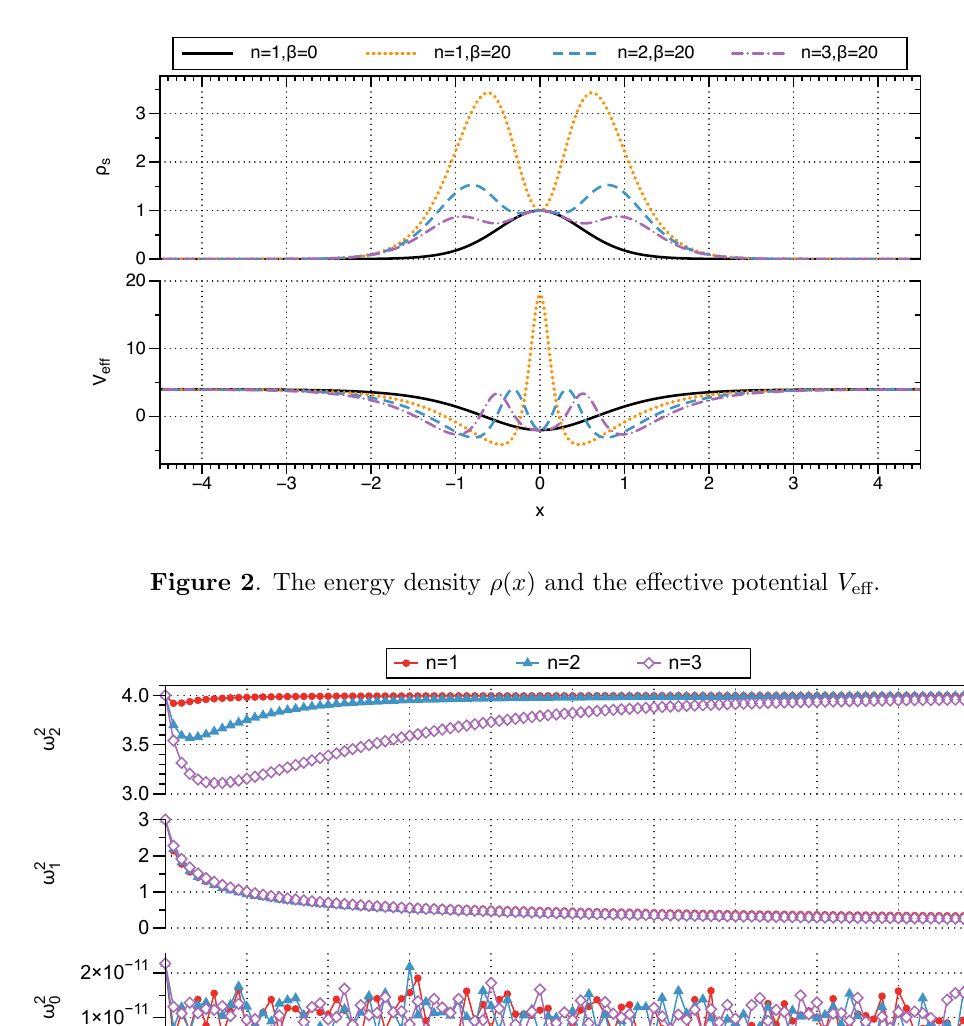
( a = 0 ; 1 ; 2) with the e(cid:11)ective potential a